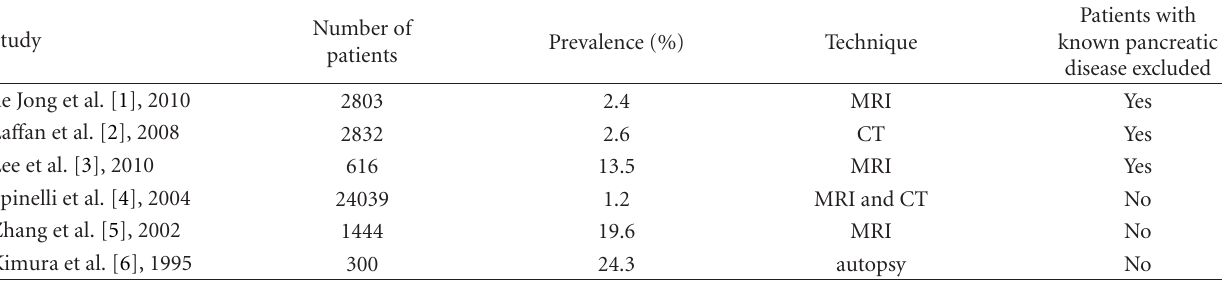
Table 1: Characteristics of studies on pancreatic cyst prevalence.